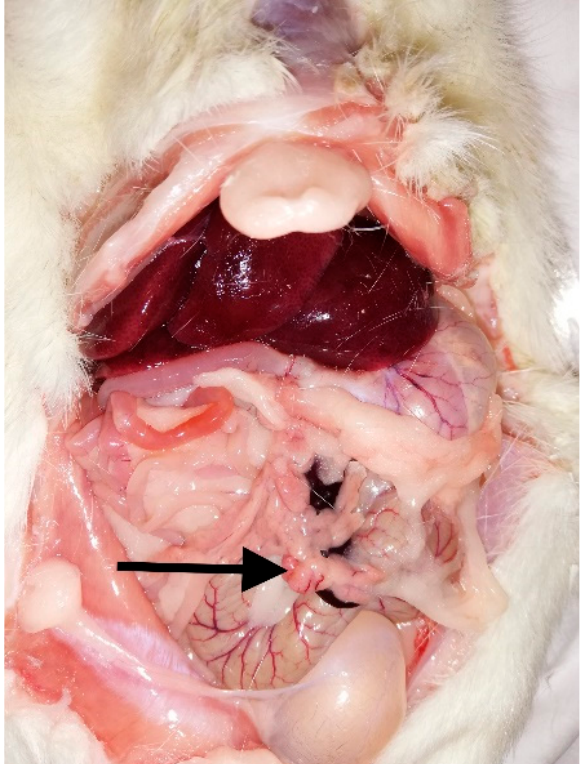
Figure 3. Postmortem image of the abdominal cavity of the rat. The arrow indicates a mass within the pancreas.